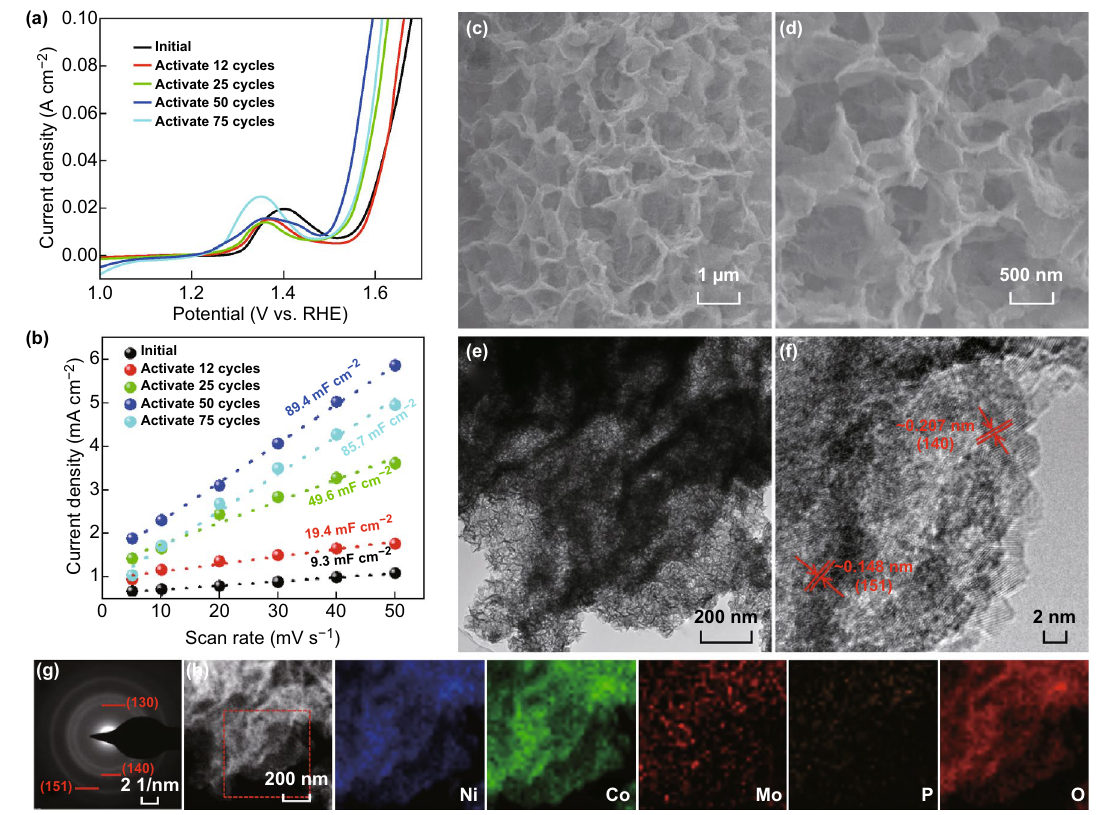
Fig. 3 a Polarization curves and b the current density against scan rates of E-Mo–NiCoP-3 with different activation cycles as indicated. c , d SEM, e TEM, f HRTEM, g SAED, and h the corresponding element mapping of